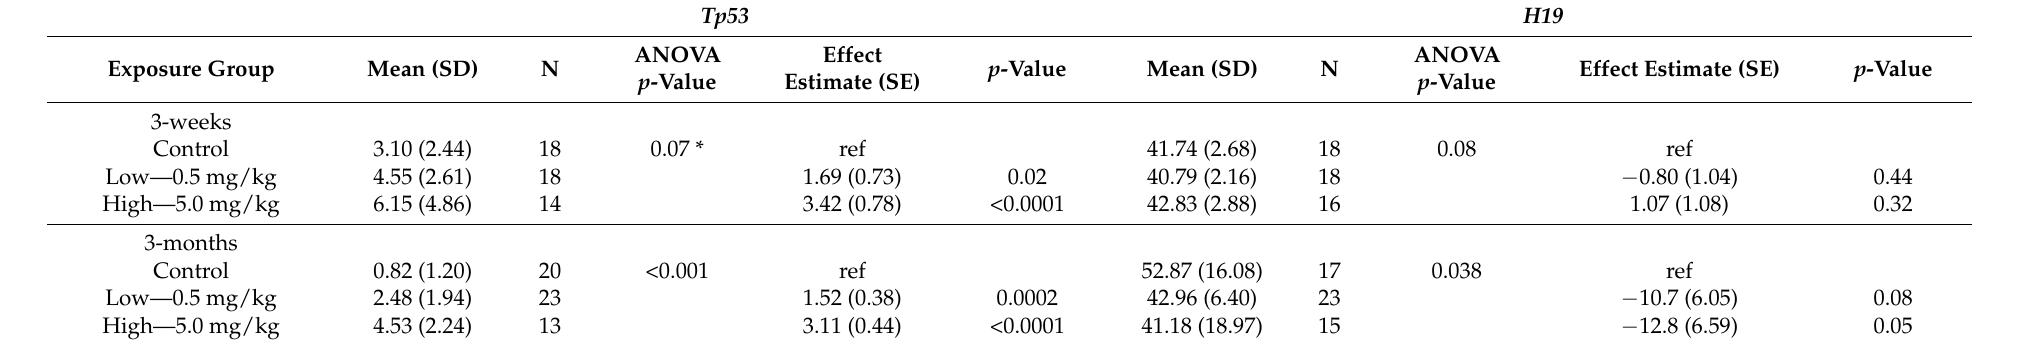
Table 4. DNA Methylation by Aflatoxin B1 Exposure Group at 3 Weeks and 3 Months of Age in